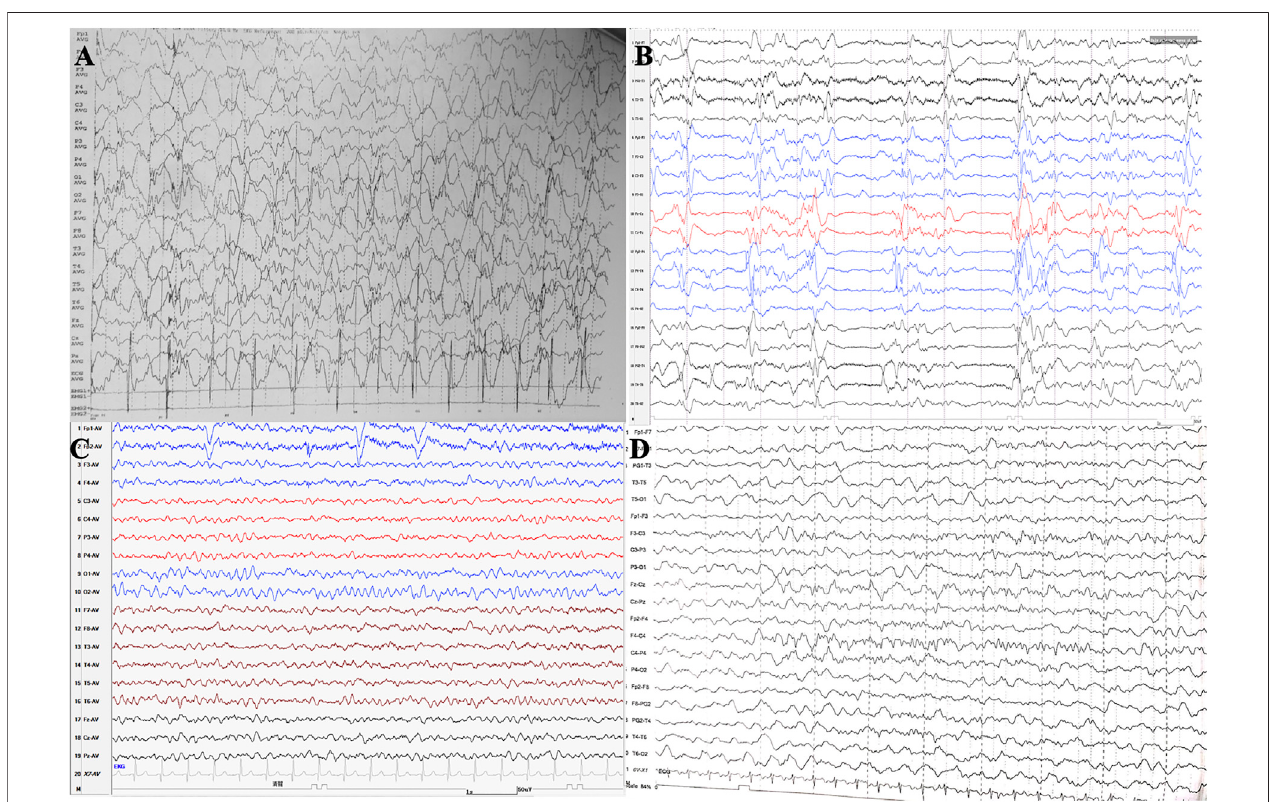
FIGURE 2 | EEGs of patient 1 (A,C) and patient 3 (B,D) . (A) EEG showed hypsarrhythmia during frequent cluster seizures of patient 1 at the age of 2 years before pyridoxine was used. (B) EEG showed burst suppression of patient 3 at the age of 1 month before pyridoxine was used. (C) EEG of patient 1 showed normal after seizures were controlled by pyridoxine for nearly 2 years. (D) EEG of patient 3 showed normal after seizures were controlled by pyridoxine for nearly 2 months.